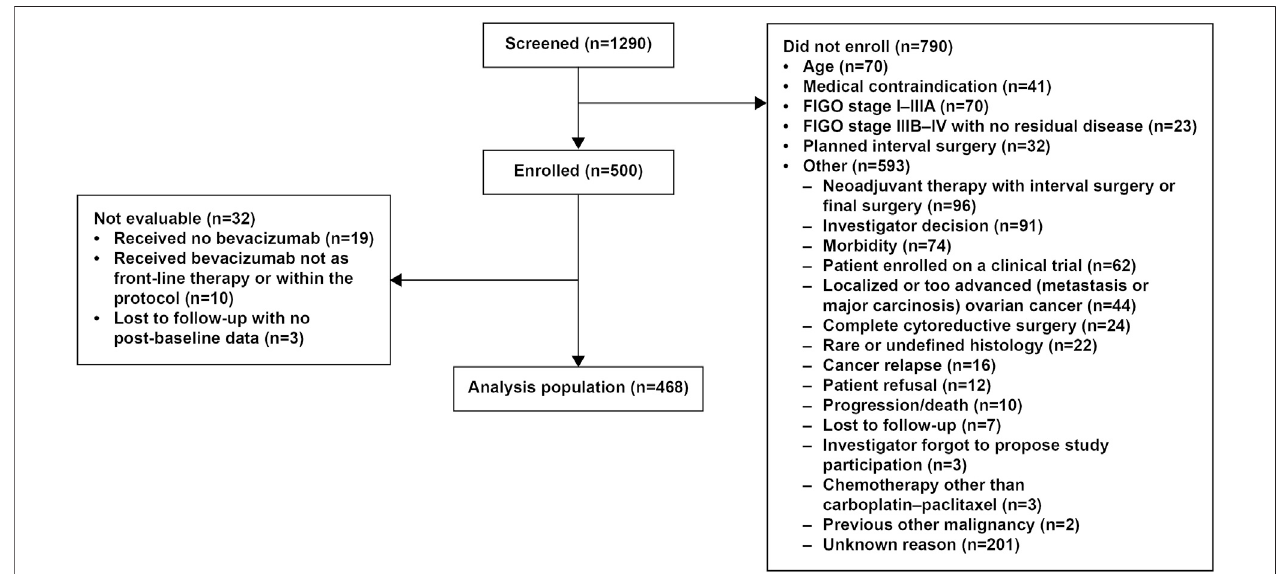
FIGURE 1 | Patient fl ow. More than one reason for not enrolling is possible. A total of 667 “ other ” reasons were reported in 593 patients.